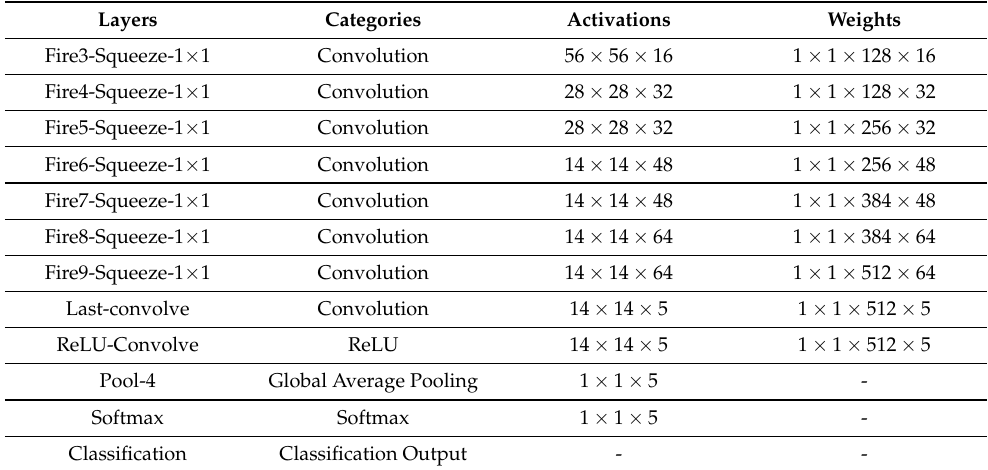
Table 4. SqueezeNet network used for guava disease detection. Layers